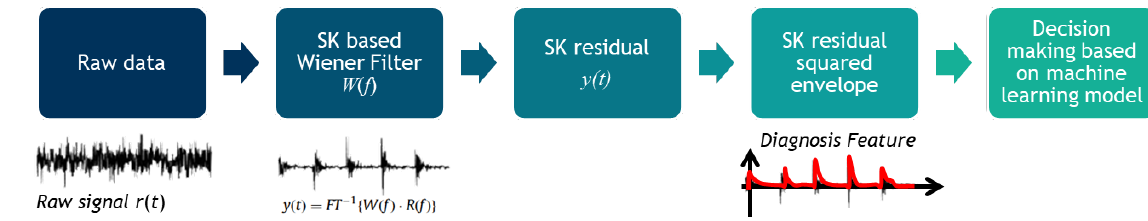
Figure 6. Spectral Kurtosis Feature extraction and filtering methodology, steps 1 is described in Section 3.2.